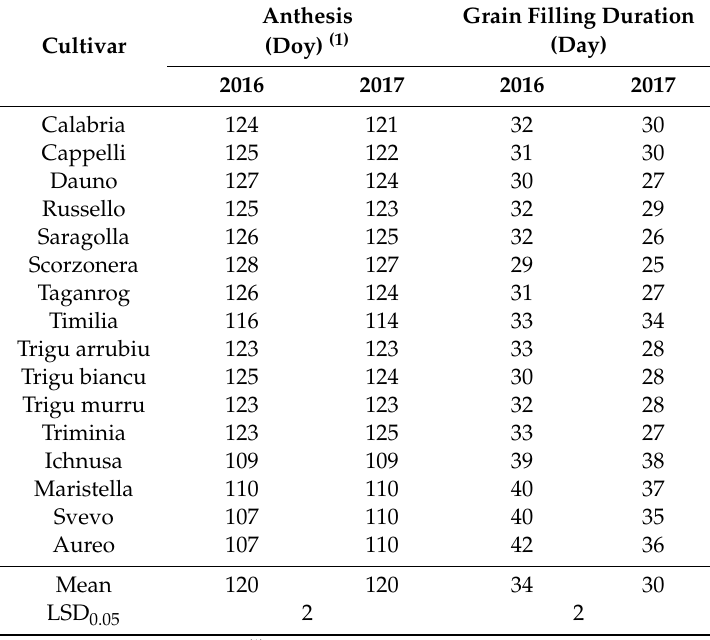
Table 2. Anthesis date and grain filling duration. Least Square Means and LSD 0.05 for the comparison of cultivar × year means at the same or di ff erent levels of